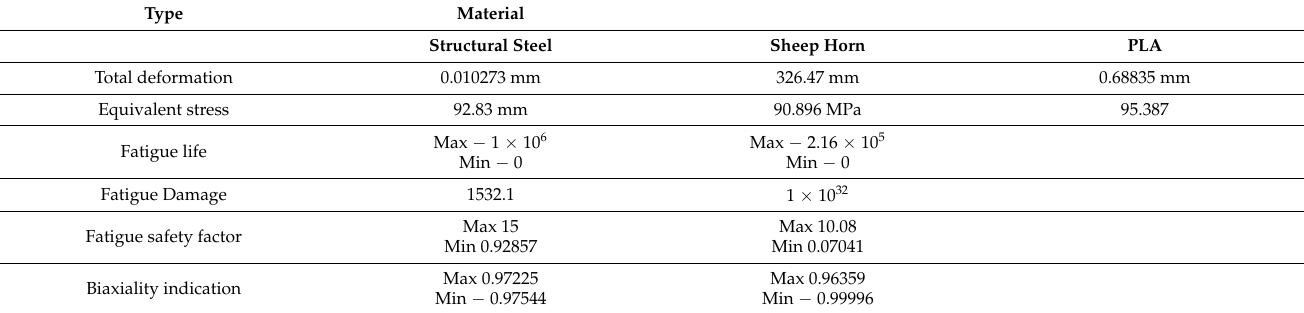
Table 4. Simulation study comparison for bamboo